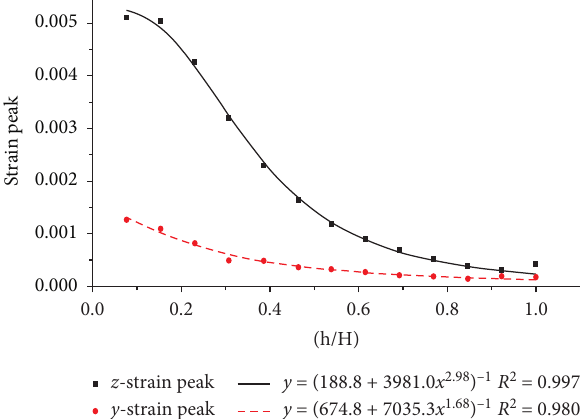
Figure 15: Distribution of the axial and radial strain peaks.